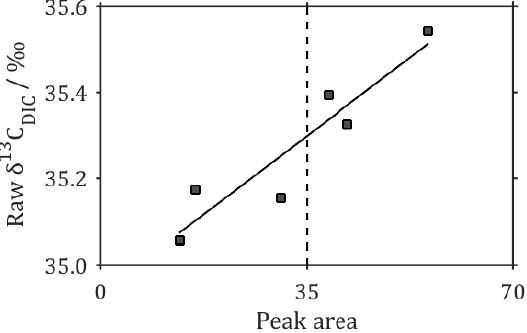
Figure 3. Peak area vs. δ 13 C relationship for homogeneous sea- water sampled at a range of volumes from 0.5 to 1.5mL (grey squares). The black best-fit line shows the relationship used to cor- rect all seawater samples for peak area, and the vertical dashed line at (peak area) = 35 indicates the peak area to which corrections have been